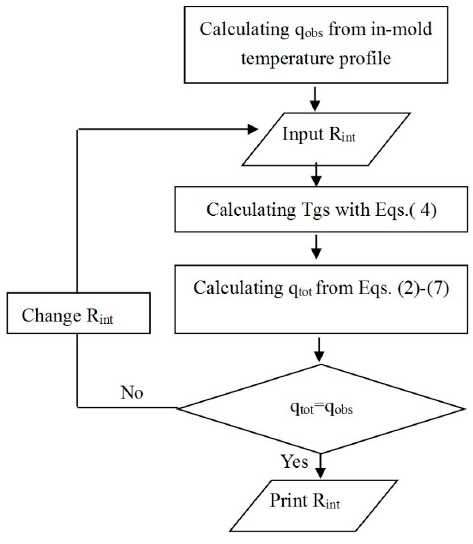
Figure 16. The flow chart for calculating R int .